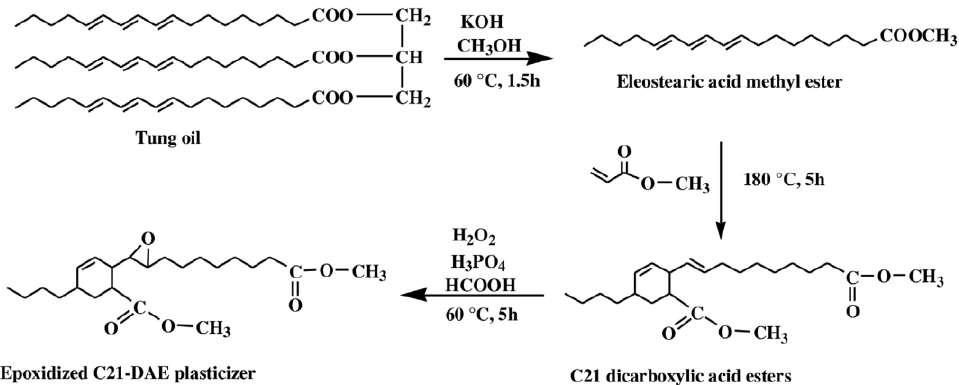
Figure 21. Synthesis of C21 dicarboxylic acid ester.